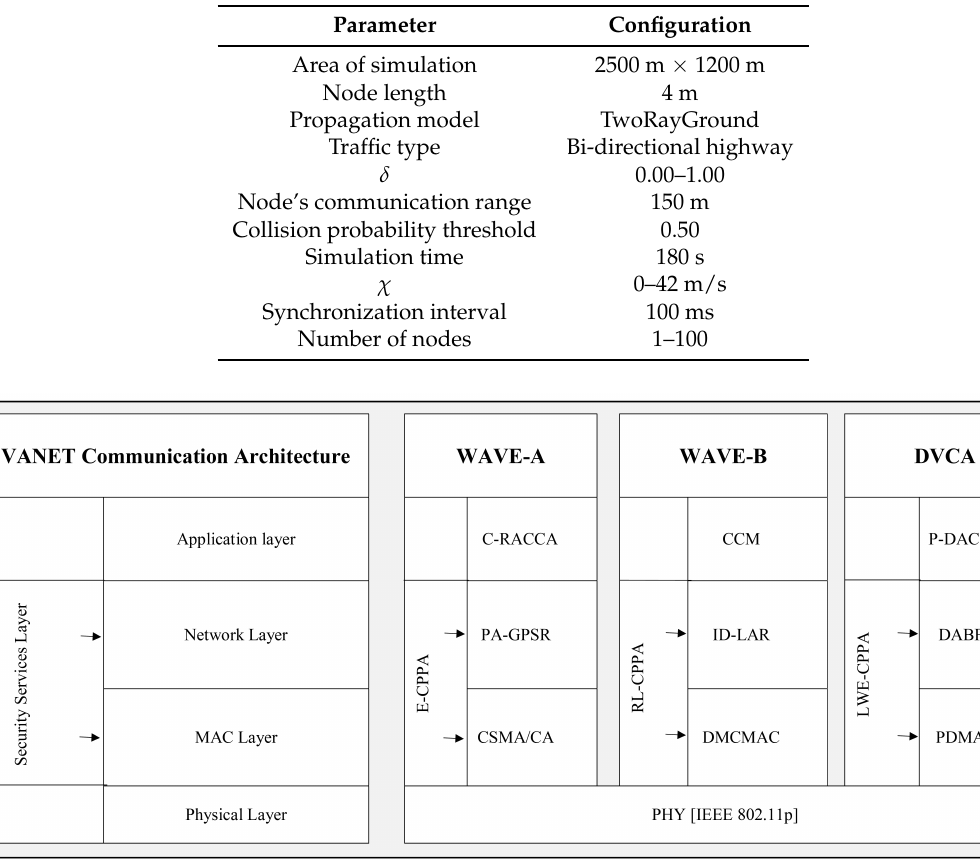
Figure 5. Comparison of VANET collision avoidance protocol